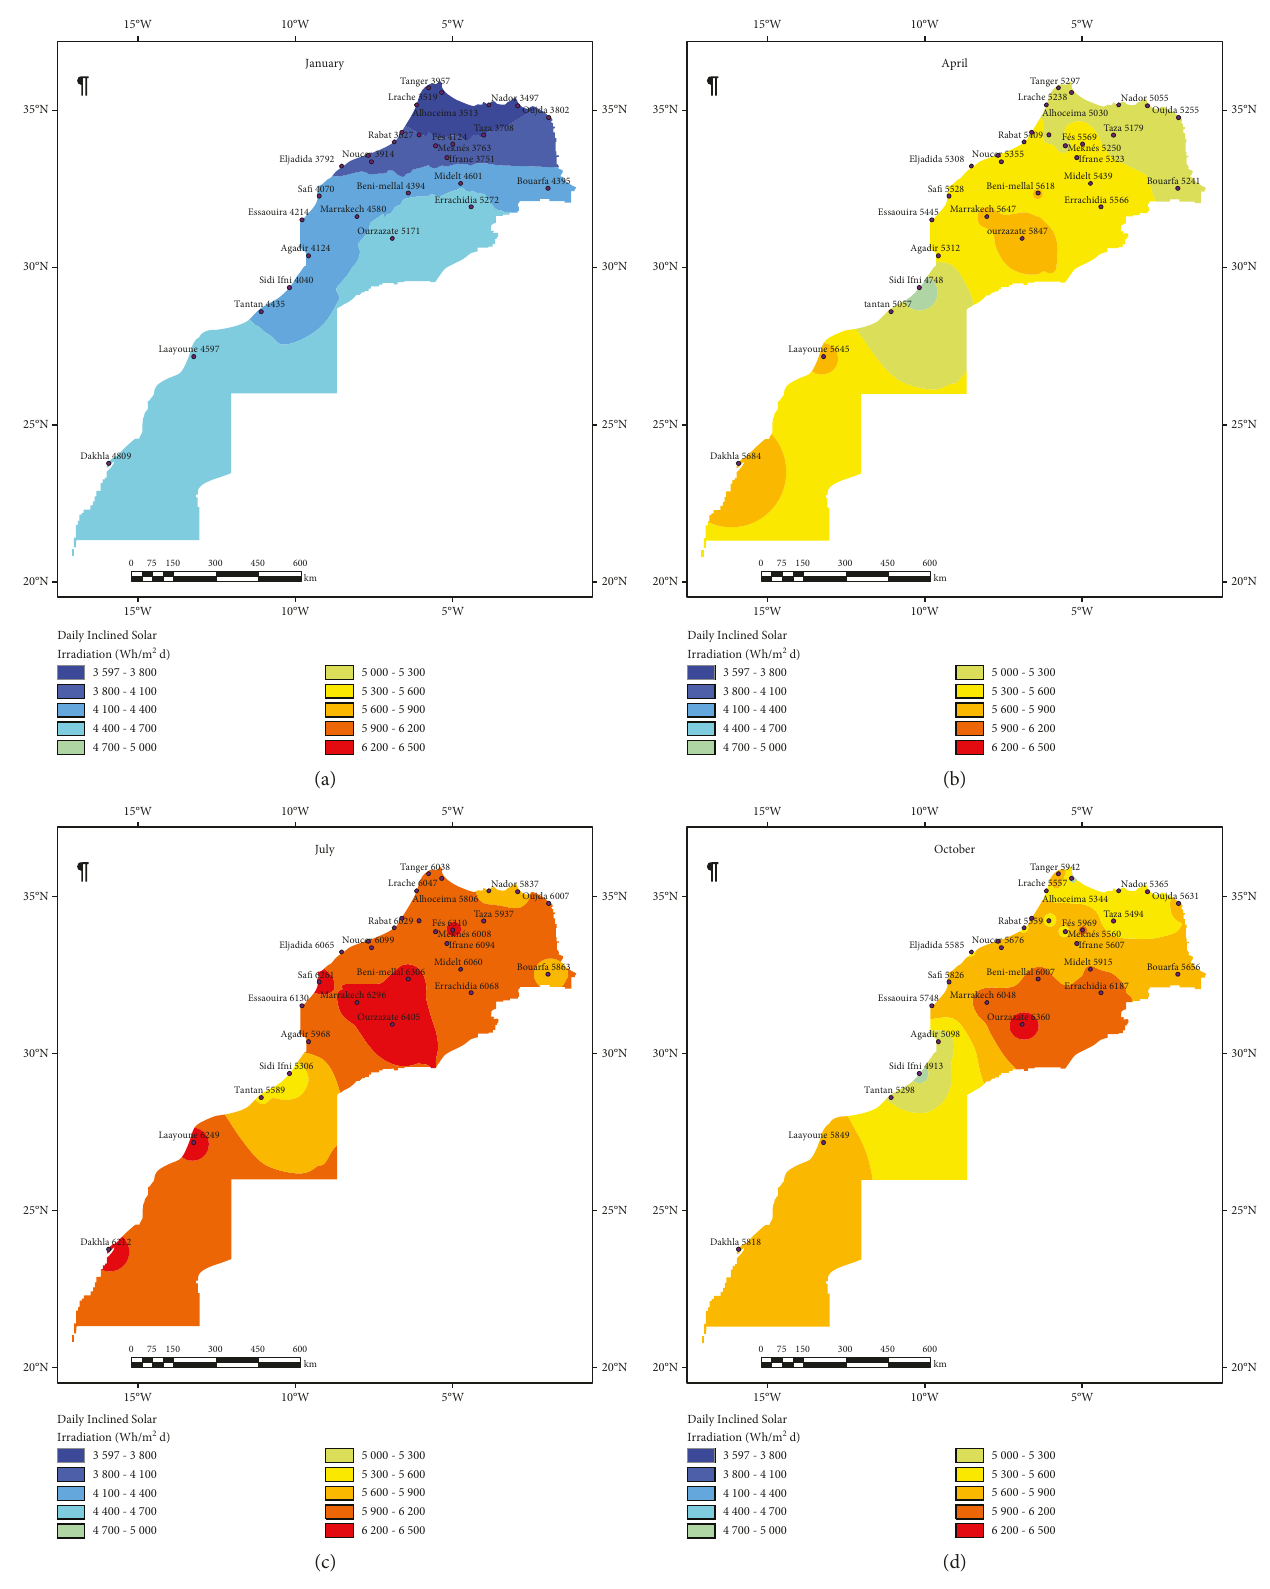
Figure 11: Maps of the monthly average values of the daily global irradiations on inclined planes ( β = the site latitude). Maps of the global solar radiation inclined with β =the latitude ’ s site (a –